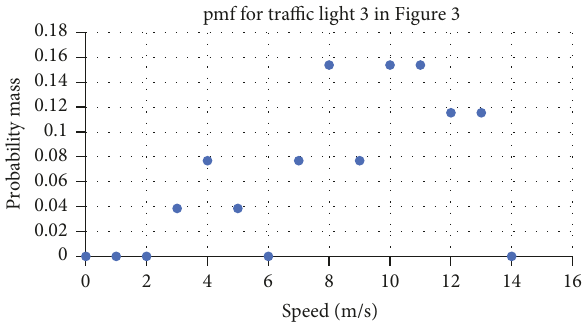
Figure 9: pmf for the speed at the traffic light id = 3 in Figure